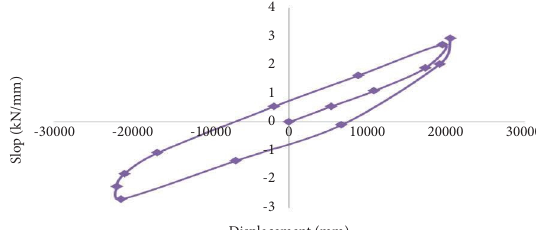
Figure 21: Defection hysteresis loop for static loading.